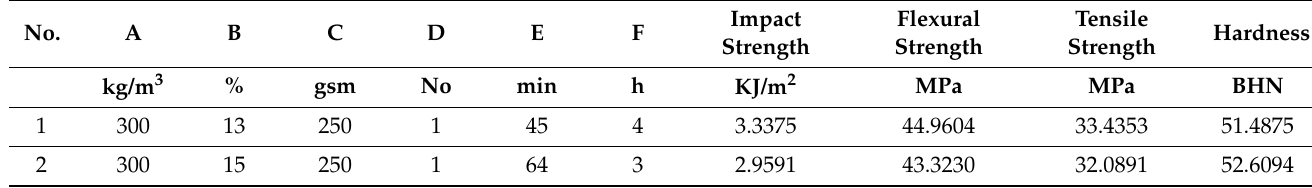
Table 9. Predicted solutions by desirability approach closer to objectives (maximised